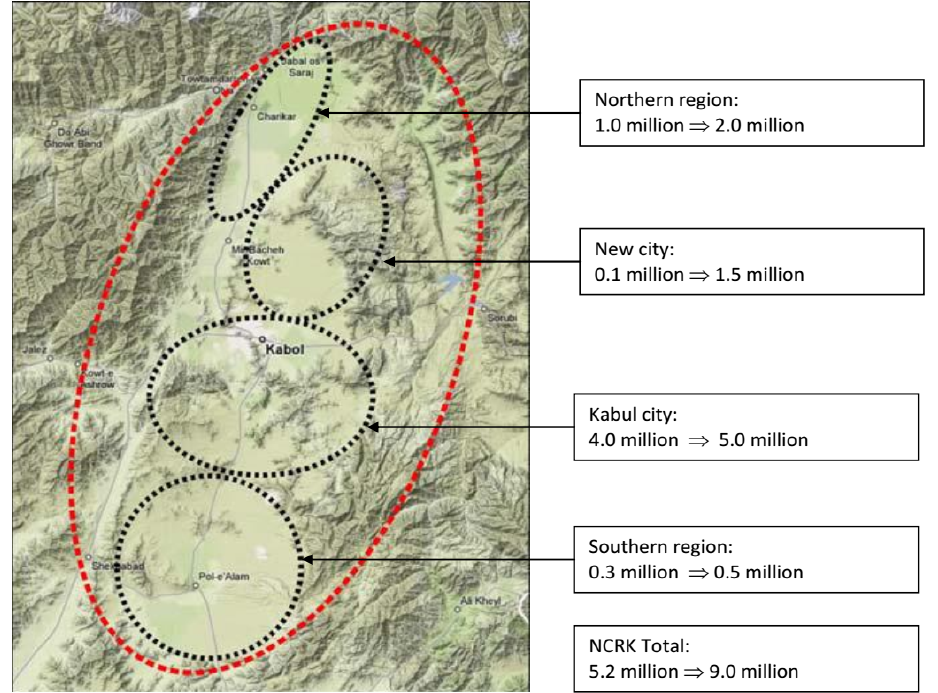
Figure 5. The population growth in Kabul from 2008 to 2015, projected by JICA [1].